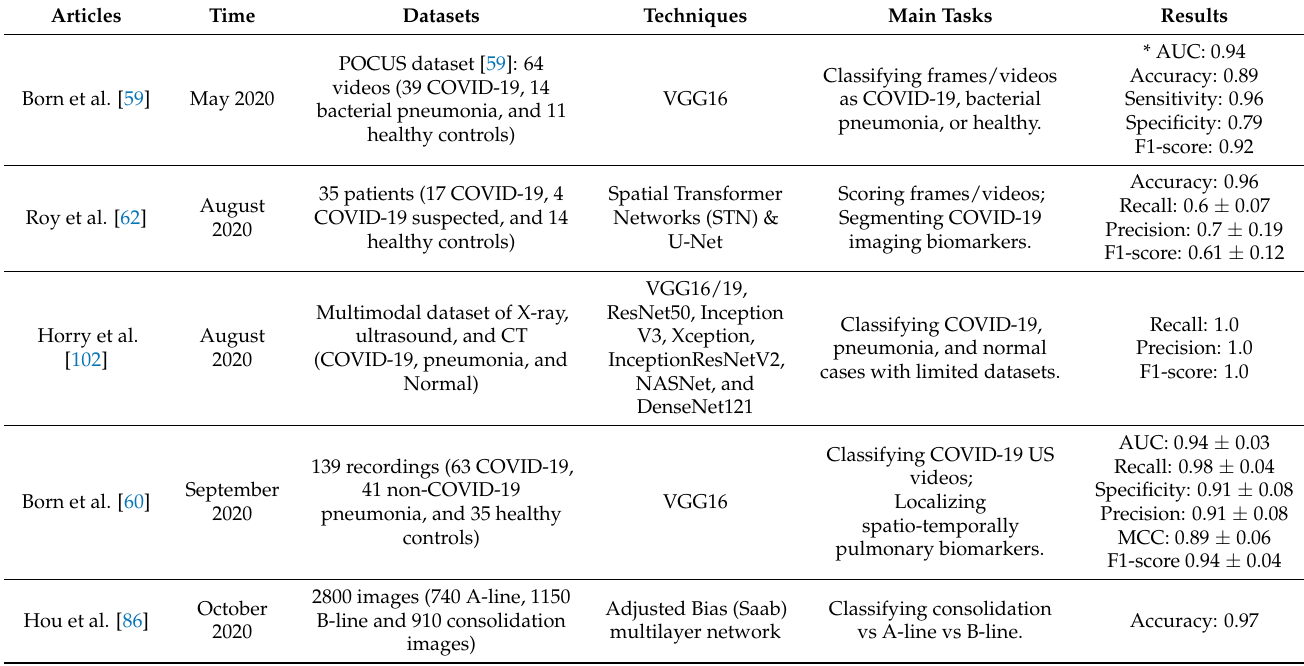
Table 2. Summary of research articles on AI applications of LUS for